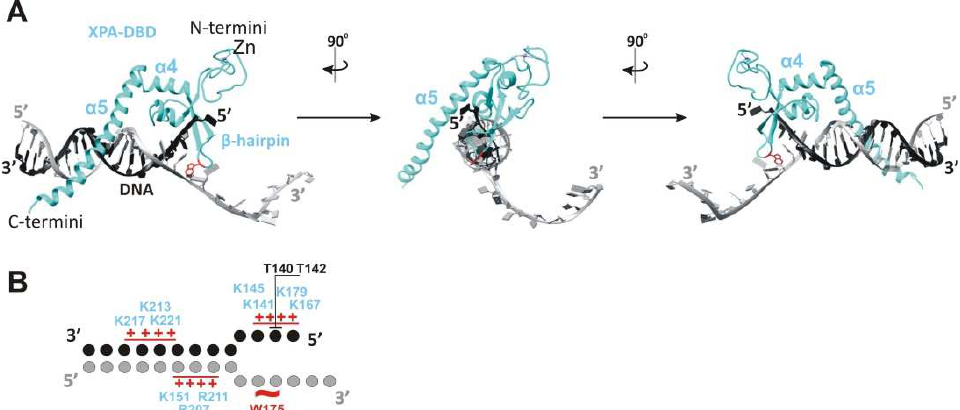
Figure 2. XPA interaction with the ss–dsDNA junction. ( A ) Cryo-EM structure PDB: 6RO4 provides details of the XPA–DBD interaction with the ss–dsDNA junction. XPA demarcates the 5 (cid:48) edge of the DNA repair bubble. XPA inserts its intercalating β -hairpin between DNA single strands at the junction. Red colored Trp175 from the tip of the β -hairpin stacks against the base of the DNA 3 (cid:48) -extension at the junction. The structures were generated using UCSF Chimera software (version 1.16). ( B ) Schematic representation of the interactions between side chains of the XPA and DNA junction, according to cryo-EM structure PDB: 6RO4 [21] and crystal structure PDB: 6LAE. DNA nucleotides are indicated as circles. Patches of positively charged residues in proximity to the DNA backbone are indicated by red pluses. Hydrogen bonding of T142 and a van der Waals contact of T140 are indicated as black